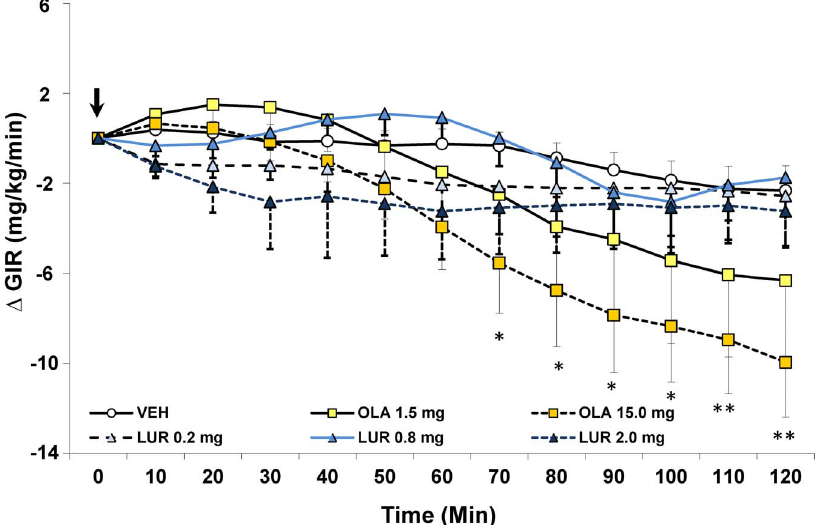
Figure 3. Acute effects of the SGA drugs lurasidone and olanzapine in adult female rats in the hyperinsulinemic-euglycemic clamp. Animals (n=6–10 per group) were fasted overnight and subjected to the hyperinsulinemic-euglycemic clamp. After animals reached euglycemia (three consecutive blood glucose readings of 6.0 6 0.4 mmol/L), rats were treated with vehicle, lurasidone (0.2, 0.8 or 2.0 mg/kg, s.c) or olanzapine (1.5 or 15 mg/kg, s.c.) in a volume 1 ml/kg. Glucose levels were recorded every 10 minutes and the glucose infusion rate was adjusted as needed. Glucose infusion rates for each treatment group are presented as change in glucose infusion rate from euglycemia. Values represent group means 6 SEM. *indicates different from vehicle-treated animals, p , 0.05; **indicates different from vehicle-treated animals, p , 0.01.